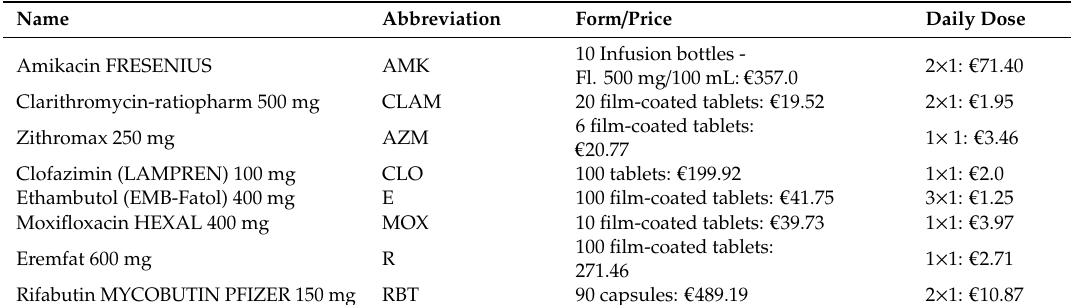
Table 1. List of medical drugs for the treatment of pulmonary disease caused by non-tuberculous mycobacteria (MAC-PD) available in Germany.